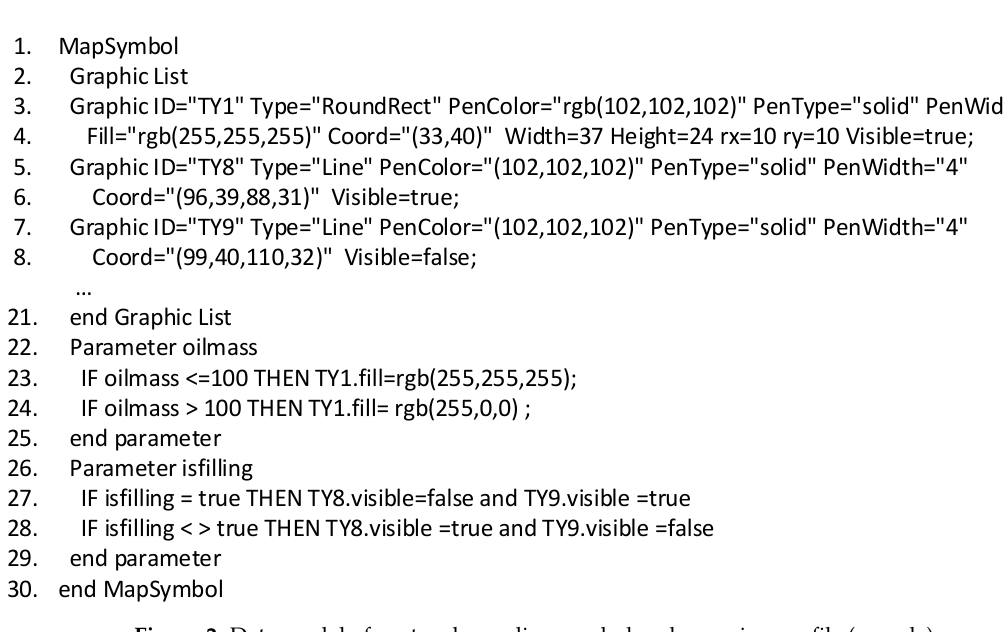
Figure 2. Data model of protocol-coupling symbol and mapping profile (sample).